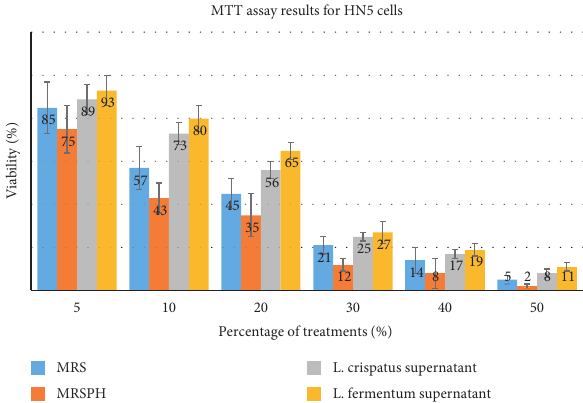
Figure 2: MTT assay results for HN5 cells.